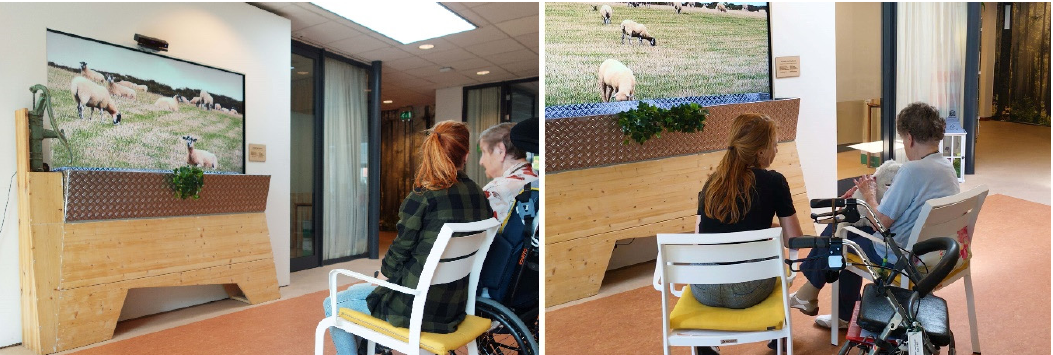
Figure 1. Design LiveNature implemented in Vitalis, including a soft-fur covered robotic sheep and an augmented reality display. The picture on the left shows an example of the interaction session with the control condition, and the picture on the right demonstrated a scenario of a participant interacting with a robotic sheep with response from the augmented reality display.